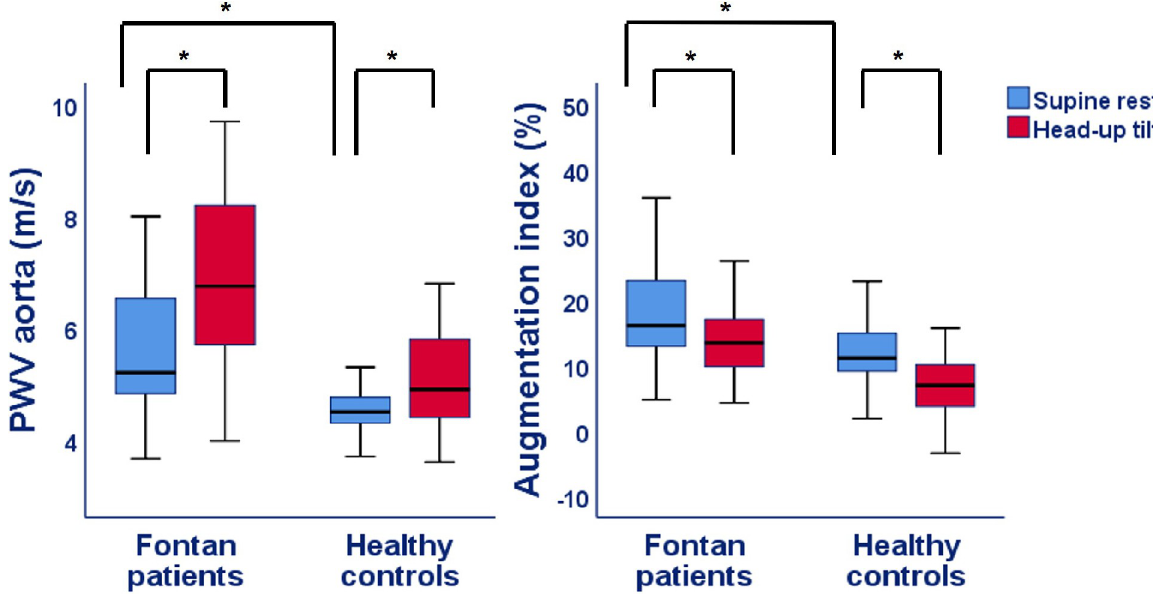
Fig 4. Aortic stiffness parameters during supine rest and head-up tilt in Fontan patients and healthy controls. PWV = Pulse wave velocity; P- value: � < 0.05 for difference in supine rest between Fontan patients and controls as well as difference between supine rest and head-up tilt within Fontan patients or healthy